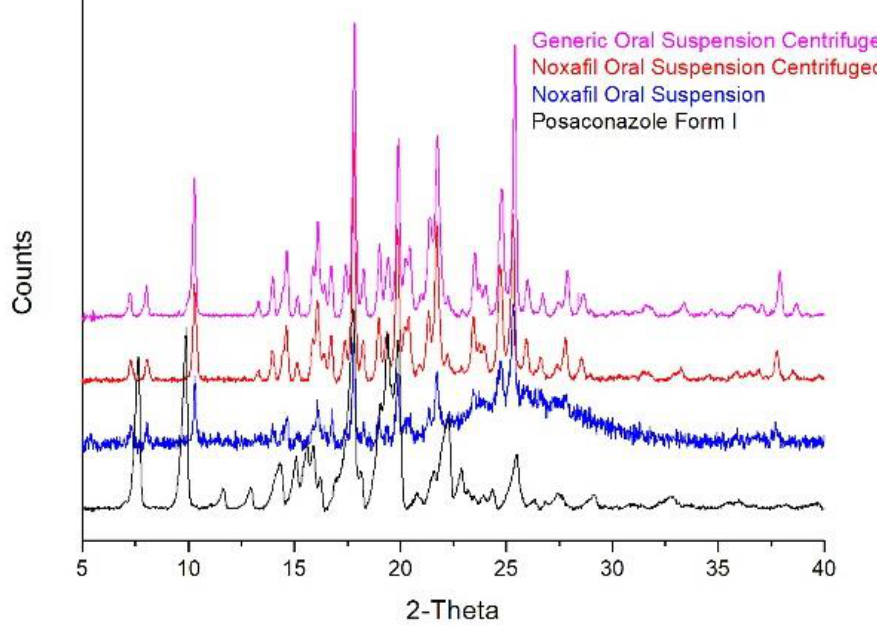
Figure 8. Comparison of the generic Posaconazole oral suspension and the reference Posaconazole oral suspension, Noxafil ® , treated with the developed sample-preparation method: The XRPD patterns of Posaconazole Form I ( black line ), Noxafil ® Posaconazole oral suspension ( blue line ), Noxafil ® Posaconazole oral suspension centrifuged and covered with the transparent food membrane ( red line ) and generic Posaconazole oral suspension centrifuged and covered with the transparent food membrane ( magenta line ).